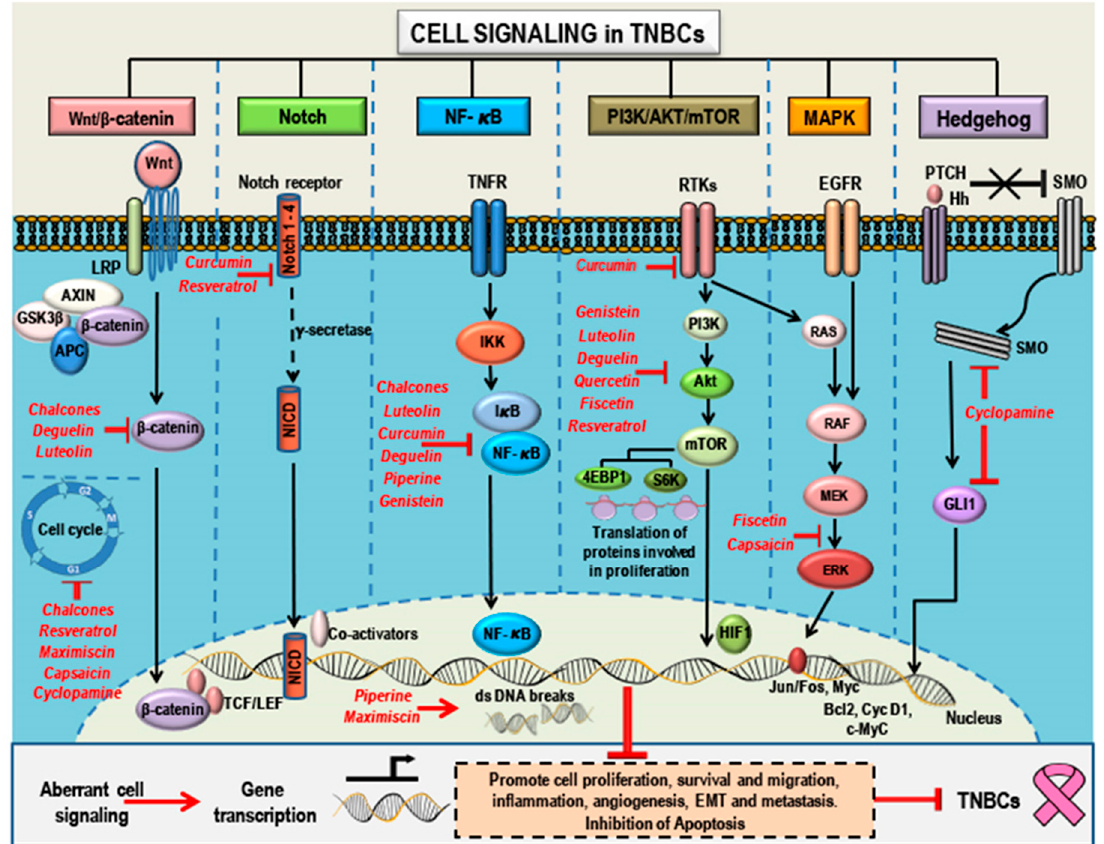
Figure 3. Natural compounds as anticancer agents in TNBCs: Mode(s) of Action. Aberrant signaling pathways (Wnt/ β -catenin, Notch, NF- κ B, PI3K/AkT/mTOR, MAPK, and Hedgehog) and pathway components that are targeted by natural compounds (highlighted in red). Phytochemicals have a broad range of action and a single anticancer phytochemical can target multiple pathways that determine cell fate. These compounds can suppress proliferation, growth, and migration; cause cell cycle arrest; induce apoptosis; inhibit angiogenesis; suppress EMT; and inhibit metastasis by targeting and modulating different pathway components and thereby regulating gene transcription and translation. This figure represents membrane, cytoplasmic; and nuclear targets of the selected natural compounds which show potential anticancer properties in TNBCs (see text for detailed mode(s) of action for the natural compounds mentioned).